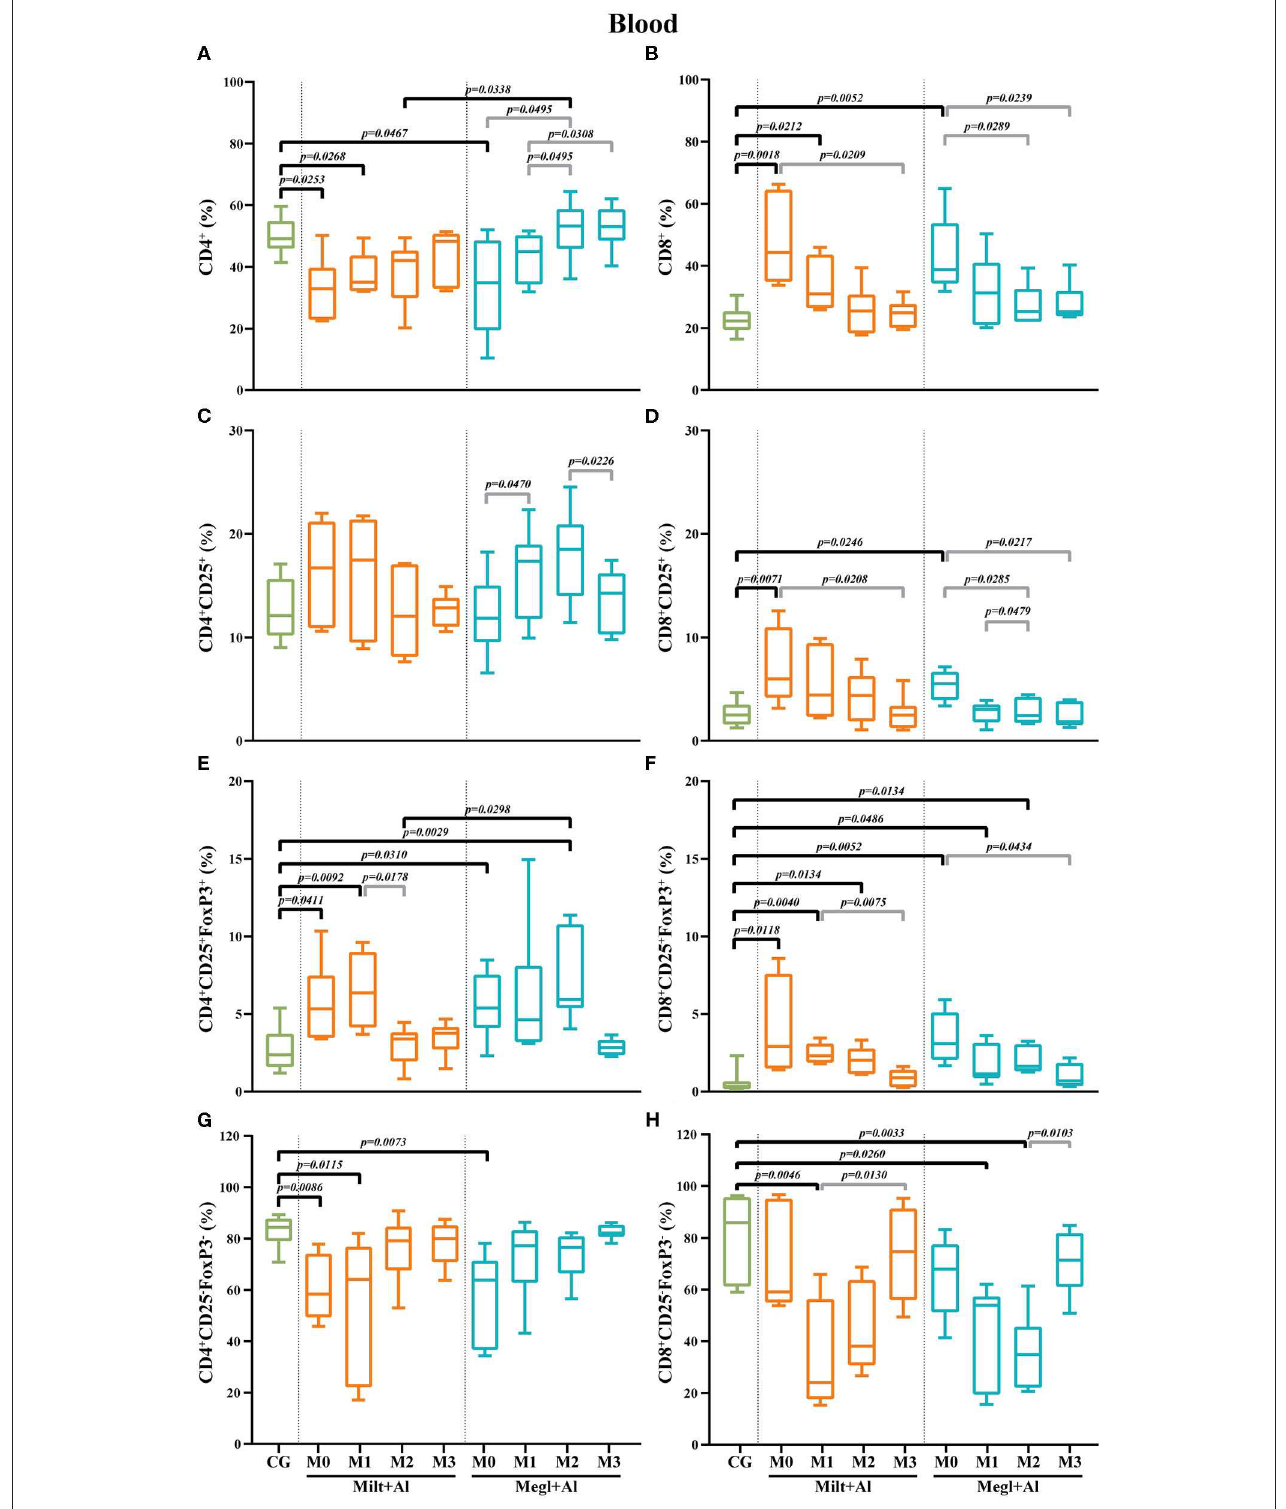
FIGURE 7 | Frequency of CD4 + (A) , CD8 + (B) , regulatory (CD25 + FoxP3 + ) (C–F) , and effector (CD4 + CD25 − FoxP3 − /CD8 + CD25 − FoxP3 − ) (G,H) T lymphocytes in the blood of healthy [control group (CG)], sick (M0), and treated dogs (M1, M2, and M3). Results of 22 dogs are represented by box and whisker plots and median, minimum, and maximum values. The non-parametric Kruskal–Wallis test (one-way ANOVA on ranks) with Dunn’s post hoc test was used for statistical comparisons between treatment groups and the CG. The repeated measures ANOVA test with Tukey’s post hoc test was used for statistical comparisons inside each treatment group. p -values are indicated in every statistically significant